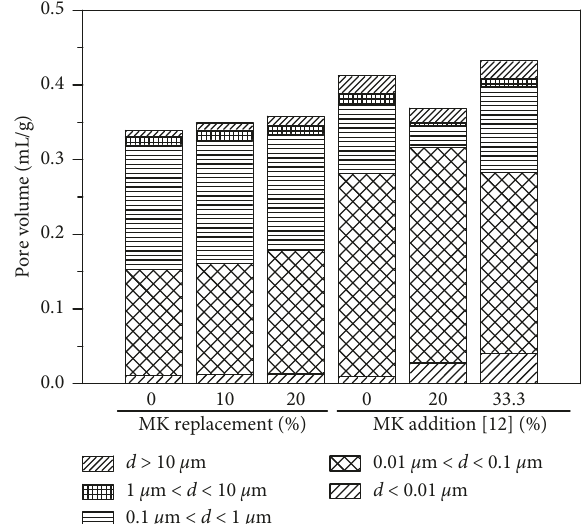
Figure 6: Pore volume of the samples treated by MK-blended